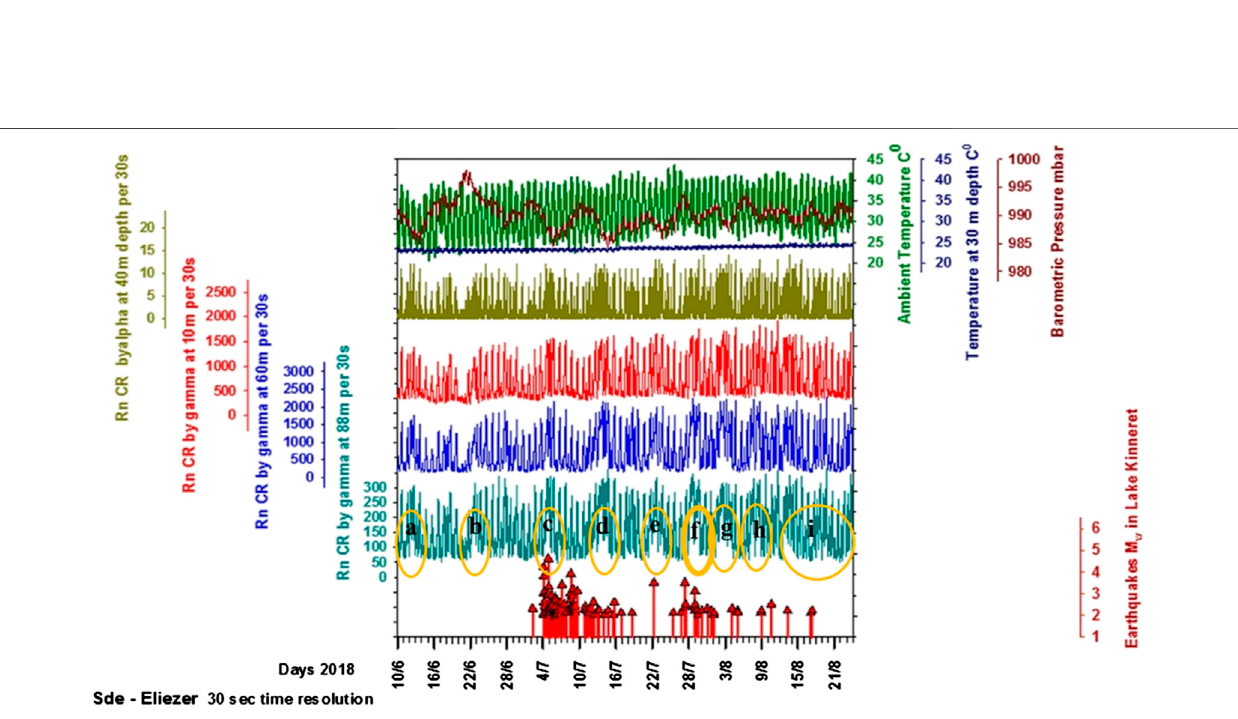
FIGURE 14 | Time series interval of 75 consecutive days at the Sde-Eliezer site. The Sde-Eliezer site is located about 35 km north of Lake Kinneret that was under weak seismic activity during July and August 2018. The non-periodic, broader than 20 h signals, on 12 ( a ) and 22 ( b ) June, 4 ( c ), 13 ( d ), 22 ( e ), and 28 & 29 ( f ) July, and2( g ),7&8( h ),and12&13( i )August,mayrevealthepre-seismicprogressionofseveralweakgeodynamiceventsindepth(detailsinFigures24,and25).Inthis fi gure, 0.1countsper 30 softhegammasensorsat10,60and88 m, areequivalent toconcentrationof1 Bq/m 3 withinthesurrounding countryrock,and 0.0015counts per 30 s of the alpha particle detector is equivalent also to 1 Bq/m 3